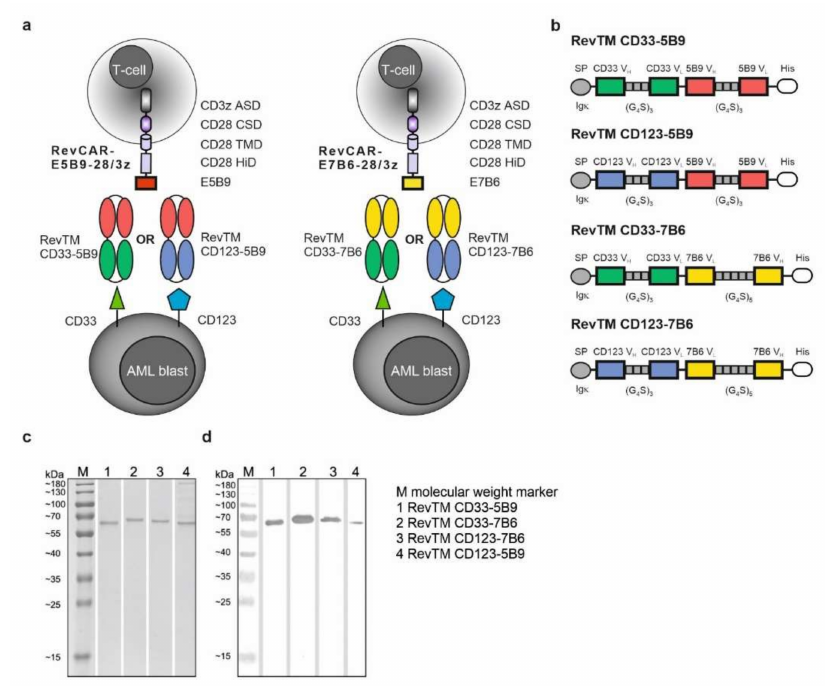
Figure 1. RevCAR platform targeting CD33 and CD123. ( a ) Schematic overview of the RevCAR system and ( b ) design of the RevTMs. ( a ) RevCARs consist of the extracellular peptide epitope E5B9 or E7B6 and CD28 (28) hinge domain (HiD), CD28 transmembrane domain (TMD), the intracellular CD28 costimulatory (CSD) and CD3 zeta (3z) activating signaling domain (ASD). RevCAR-E5B9- 28/3z or RevCAR-E7B6-28/3z modified T-cells are redirected towards CD33 or CD123 expressed on AML blasts via adaptor target modules, named RevTMs. RevTMs are bispecific antibodies (bsAbs) consisting of two different single-chain fragments variable (scFvs) binding on the one hand to E5B9 or E7B6 of the RevCAR and on the other hand to CD33 or CD123 on the surface of AML blasts. ( b ) In detail, the scFvs of the RevTMs are constructed with the variable heavy (V H ) and light chain (V L ) domains derived from the monoclonal antibodies (mAbs) CD33, CD123, 5B9, or 7B6 connected via glycine (G)-serine (S) linkers. RevTMs are expressed in eukaryotic cell lines and secreted into the cell culture supernatant mediated by the Ig kappa leader sequence (Igk). After purification via histidine tag (His), RevTMs were separated by SDS-PAGE and analyzed using Coomassie staining ( c ) and immunodetection after blotting on nitrocellulose membrane via anti-His Ab and AP-conjugated anti-mouse Ab ( d ). The whole western blot figures can be found in Figure